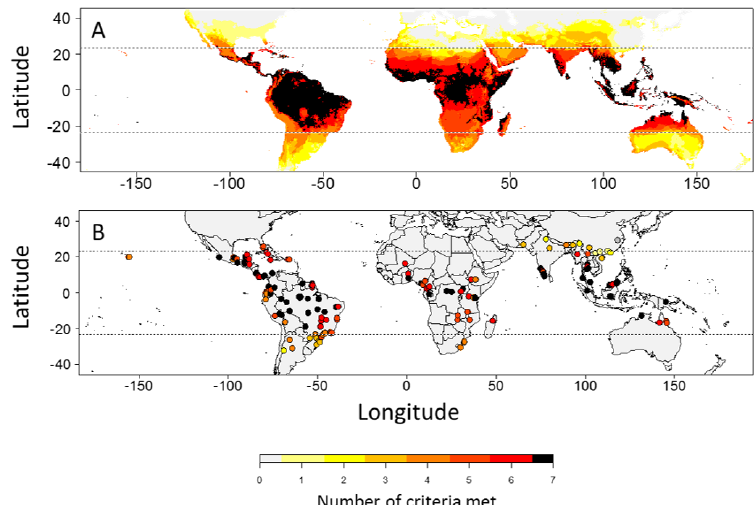
Figure 2. Where are the tropics and where are tropical studies being conducted? (a) The number of climatic criteria (Criteria 2-8) satisfied (23.4 o S and 23.4 o N as defining Criterion 1 are shown as horizontal dashed lines). The core tropics where all criteria are met are colored black. (b) The location of recent “tropical studies” published in Biotropica and the Journal of Tropical Ecology (See Supplemental Table 1 for article citations and information). The color of points indicates the number of climatic criteria (criteria 2-8) satisfied (23.4 o S and 23.4 o N as defining Criterion 1 are shown as horizontal dashed